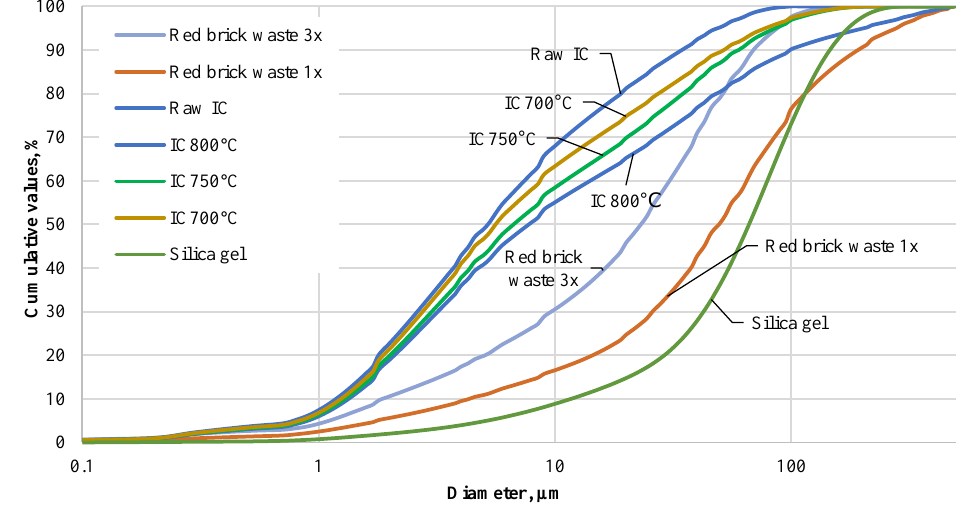
Figure 1. Particle size distribution of AAM precursors.